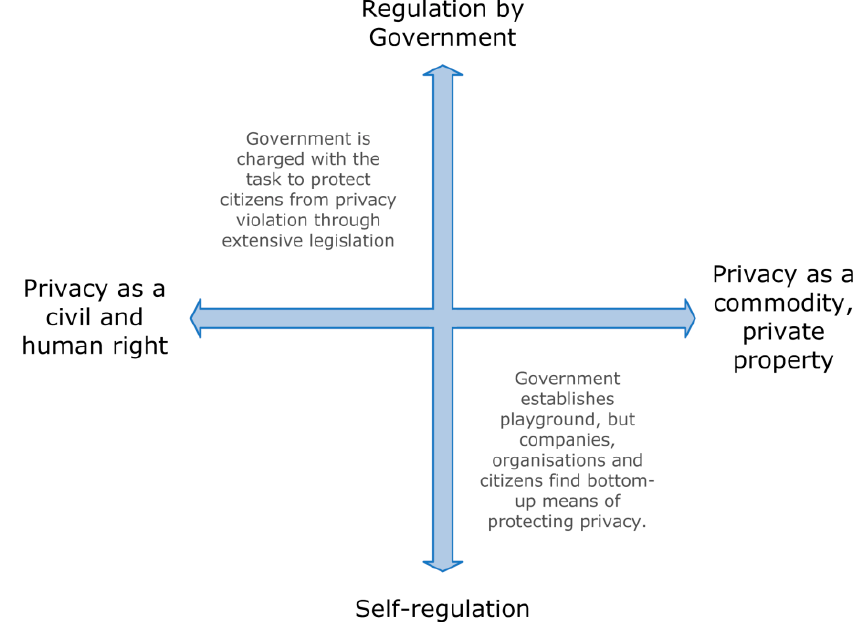
Figure 1. Different Understandings of Privacy and the Roles of Governments (Resch et al. 2012).